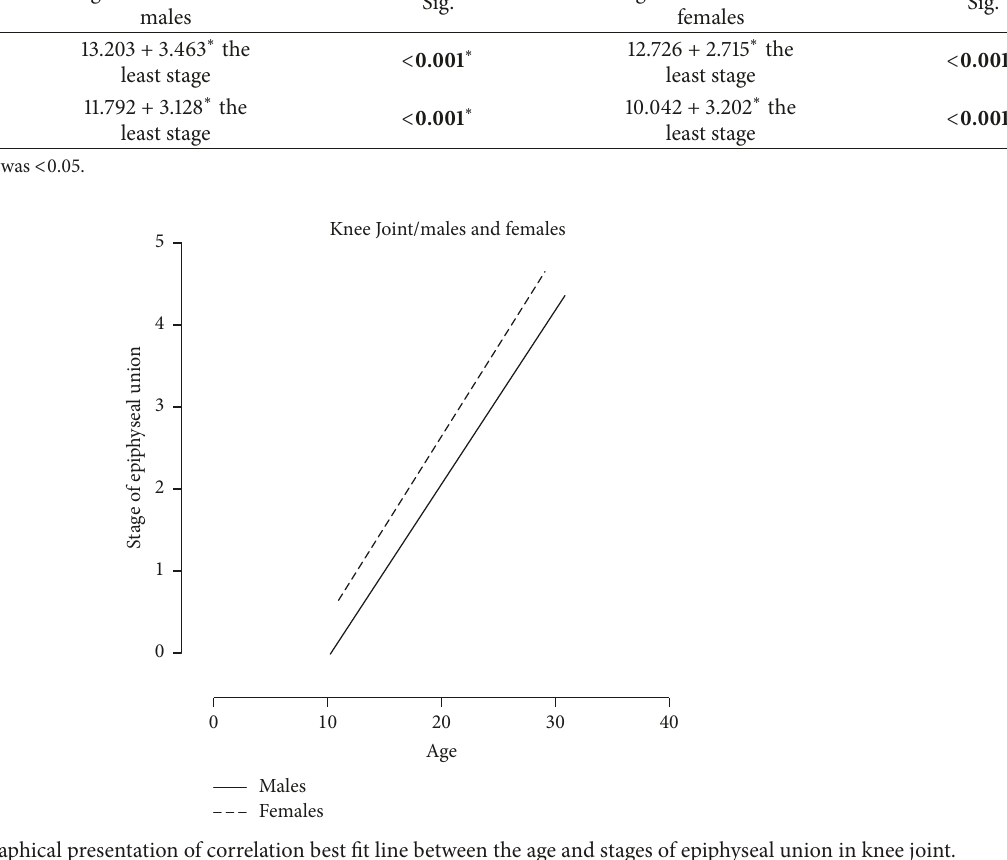
Figure 7: The graphical presentation of correlation best fit line between the age and stages of epiphyseal union in knee joint.